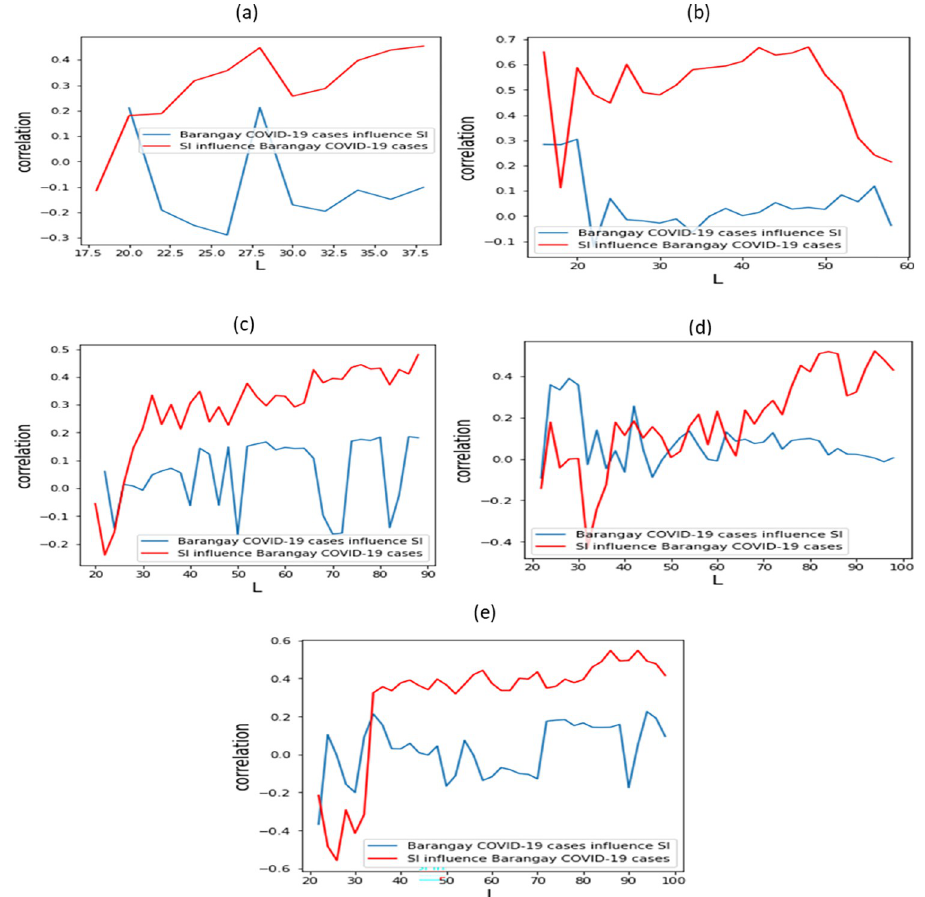
Fig 6. CCM applied in a granular administrative level in the following barangays (a) Oranbo, Pasig City; (b) Dela Paz, Pasig City; (c) Caniogan, Pasig City; (d) Payatas, Quezon City; and (e) Commonwealth, Quezon City.